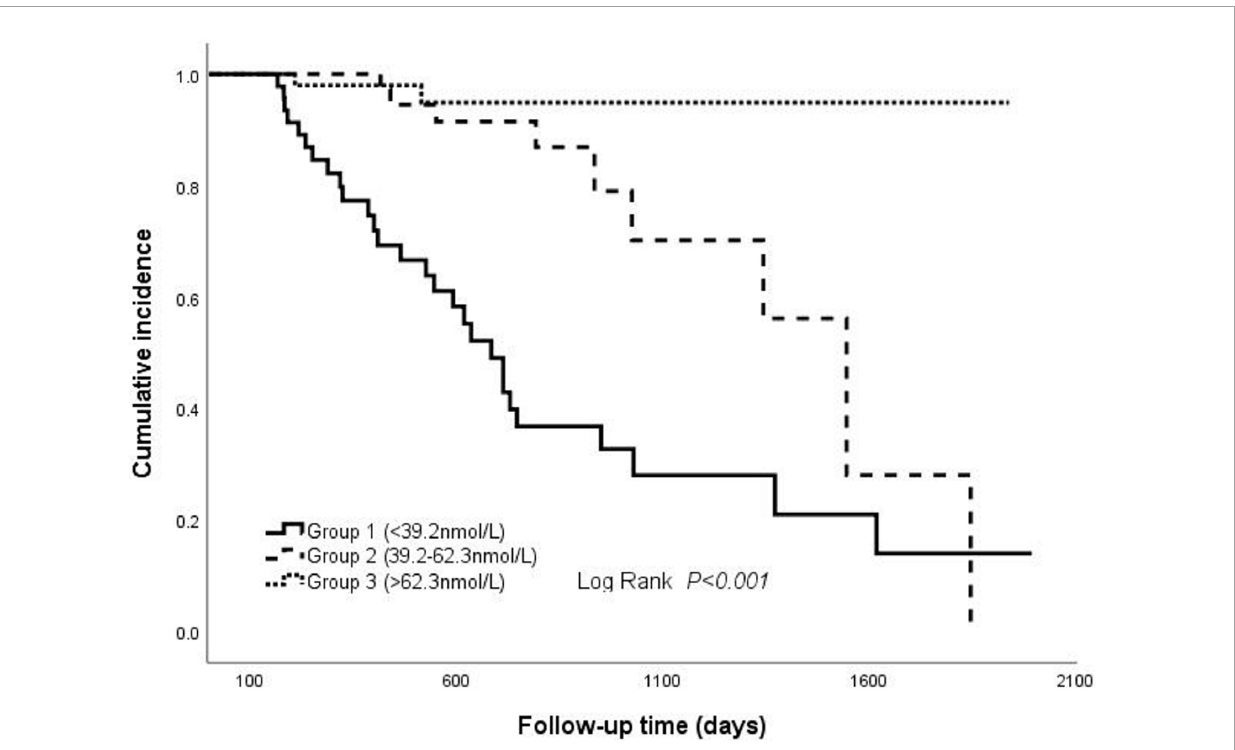
FIGURE3 Cumulative incidence of CR and PR between different groups shown by the Kaplan–Meier survival curve. The groups were stratified according to the tri-sectional quantiles of follow-up 25(OH)D levels. The difference among the three groups was tested by a log-rank test ( P <